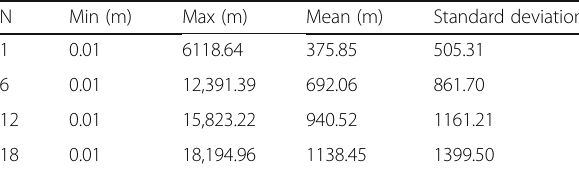
Table 3 Distance between base station and its N nearest neighbors N Min (m) Max (m) Mean (m) Standard